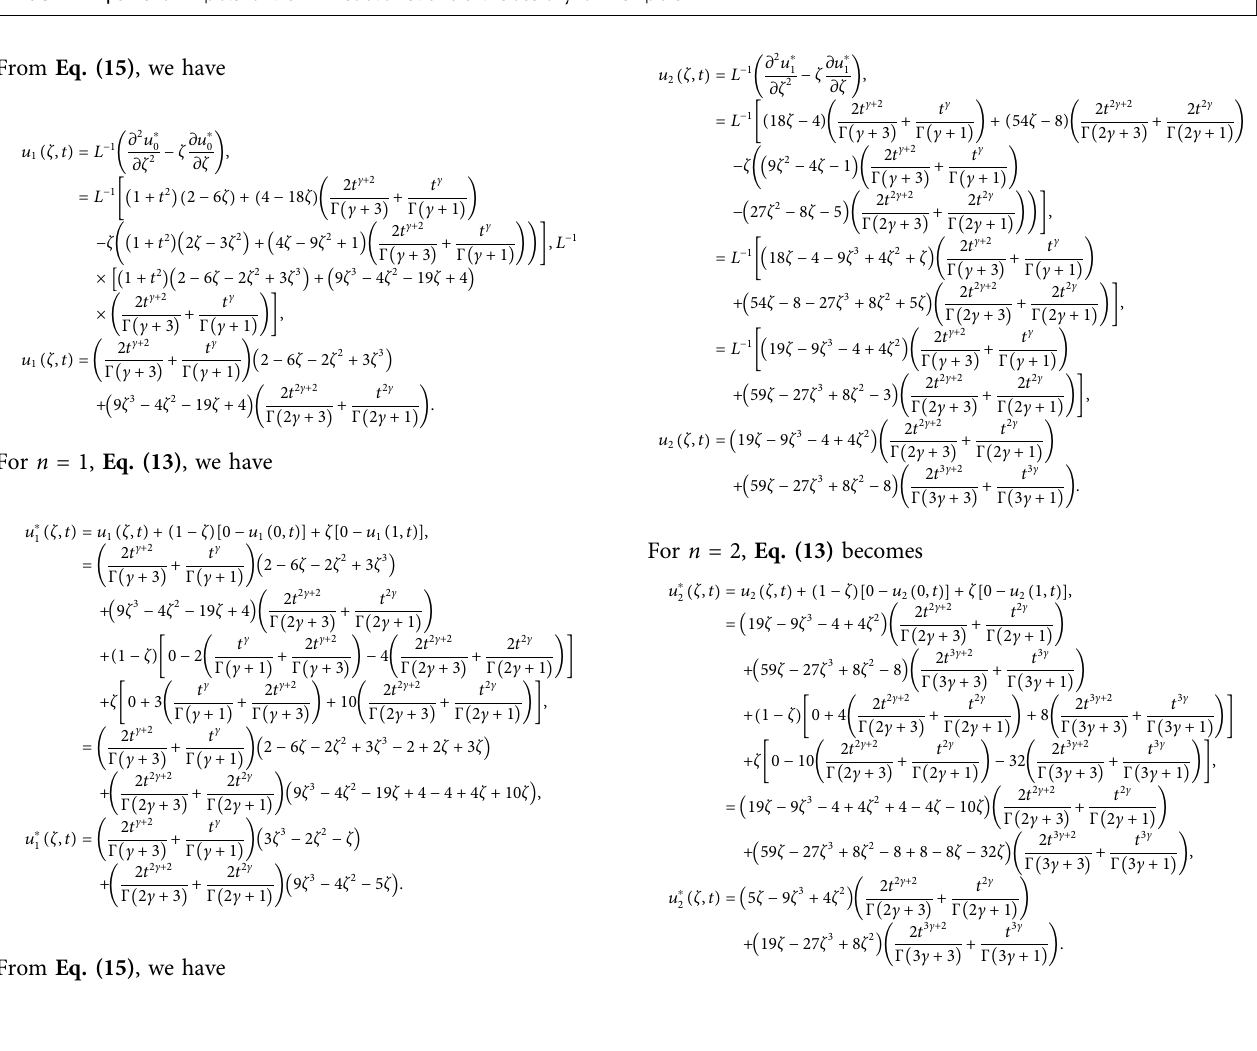
FIGURE 12 | 3D and 2D plots for the ADM solution at different values of γ for Example